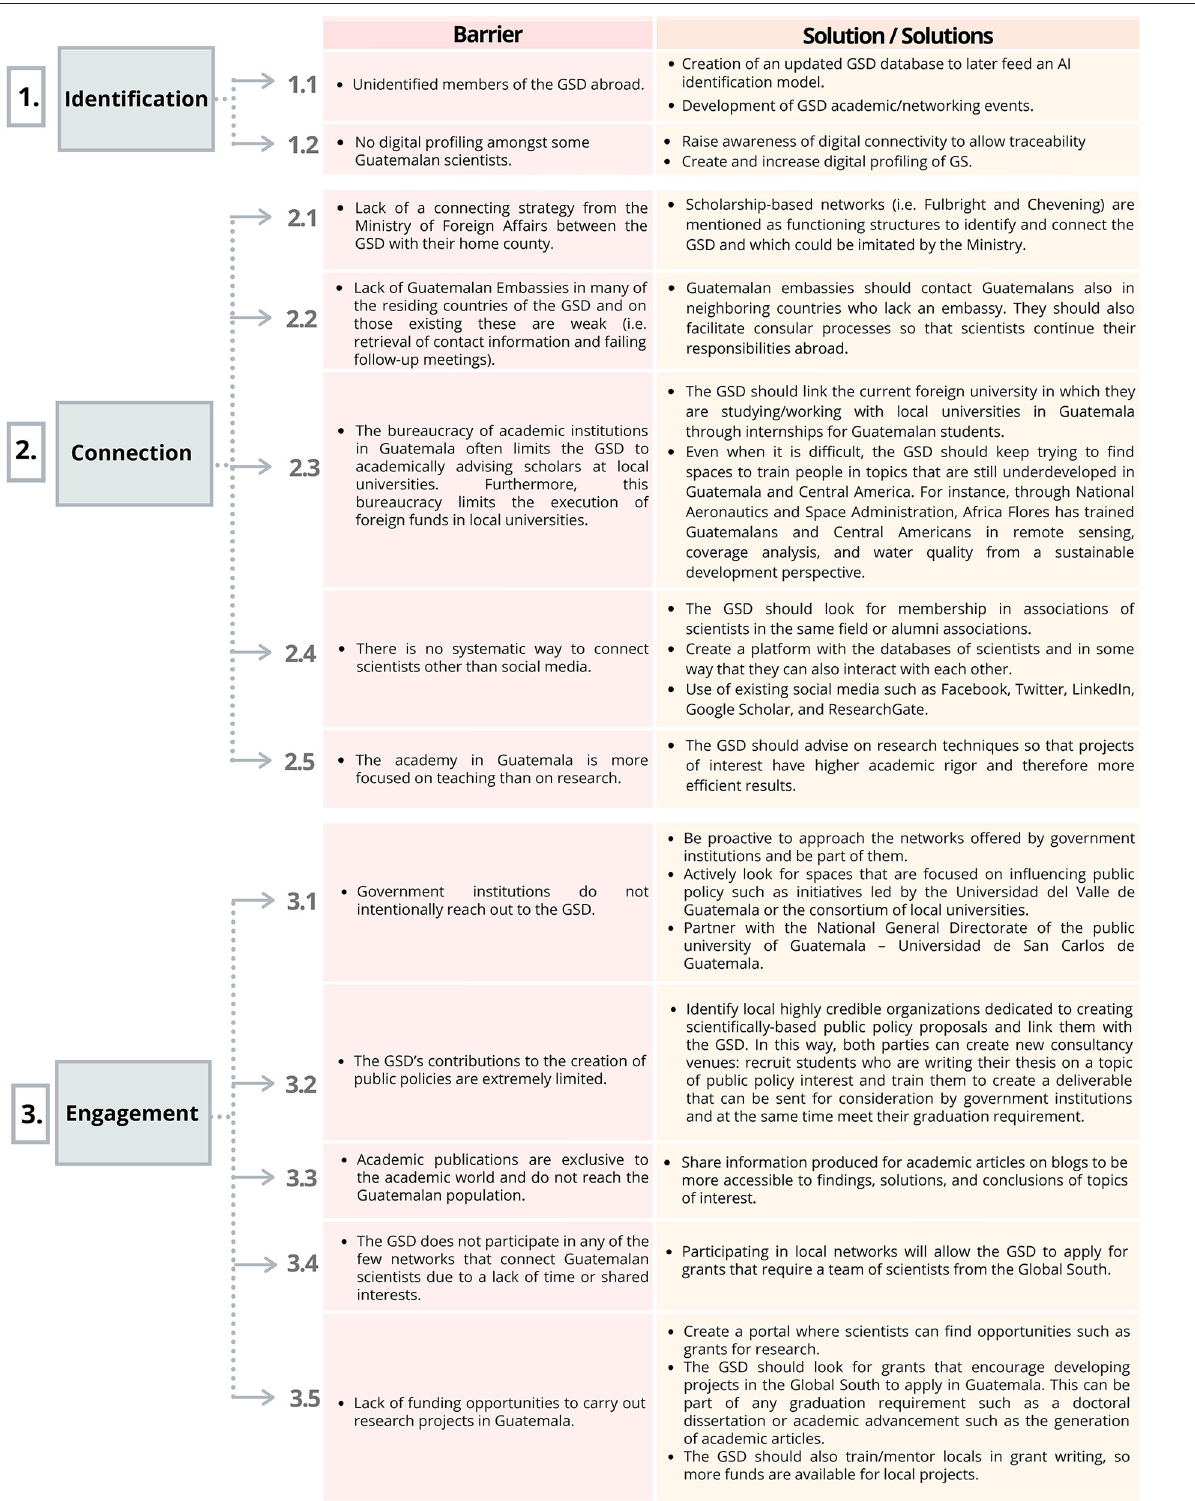
Frontiers in Research Metrics and Analytics |